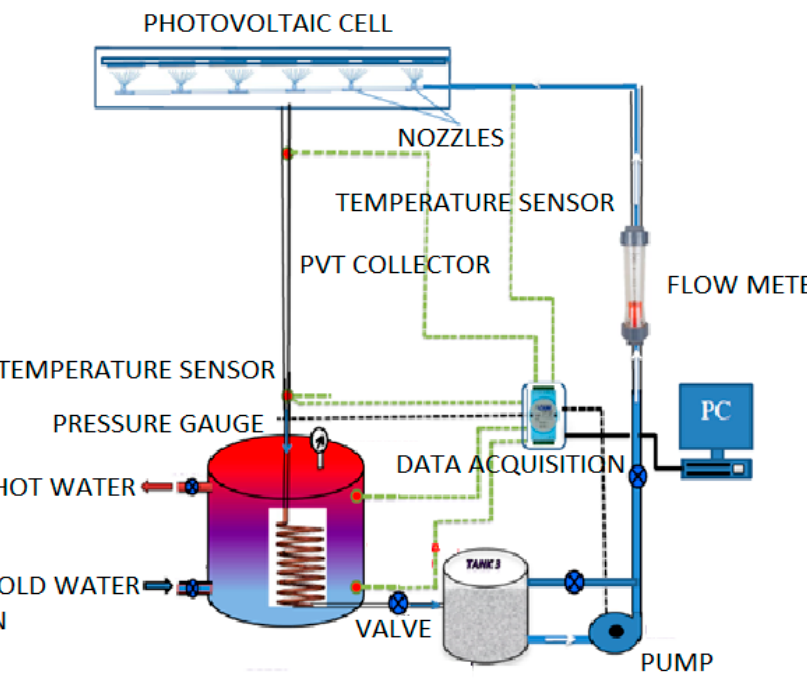
Figure 3. The schematic diagram of the PVT collector with compound parabolic concentrators.